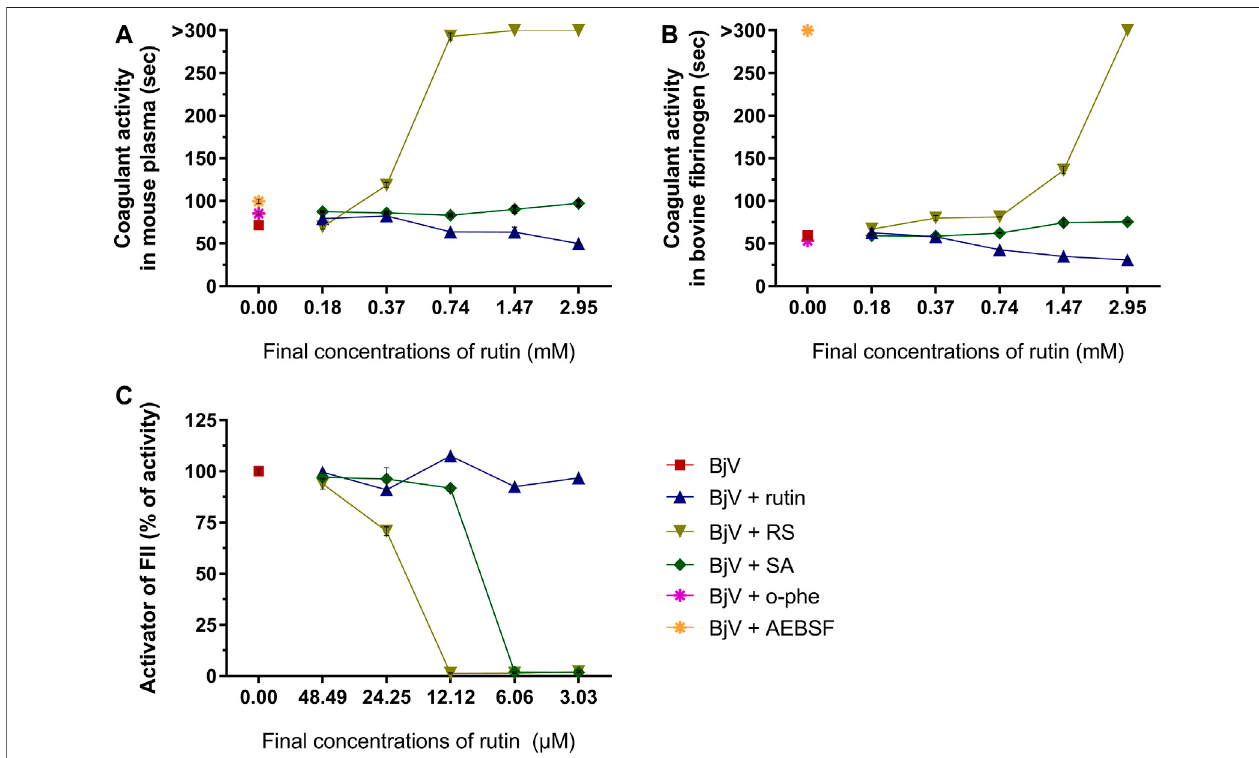
FIGURE 11 | Activity of rutin, RS or AS at different concentrations on BjV activities in vitro : (A) clotting of mouse plasma or (B) bovine fi brinogen. Data were expressed as clotting activity in seconds after the addition of BjV (0.25 mg/ml). (C) Prothrombin activation. Data were expressed as percentage of activity, and assays were carried out in